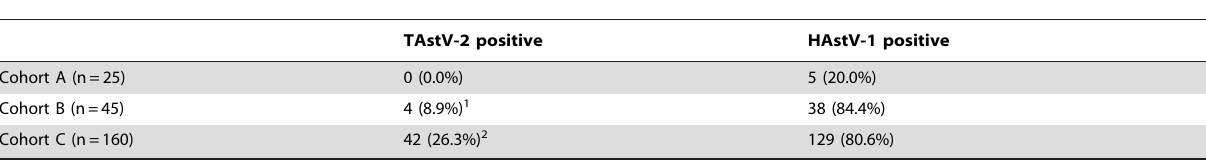
Table 1. Serologic results of TAstV-2 and HAstV-1 antibody testing.